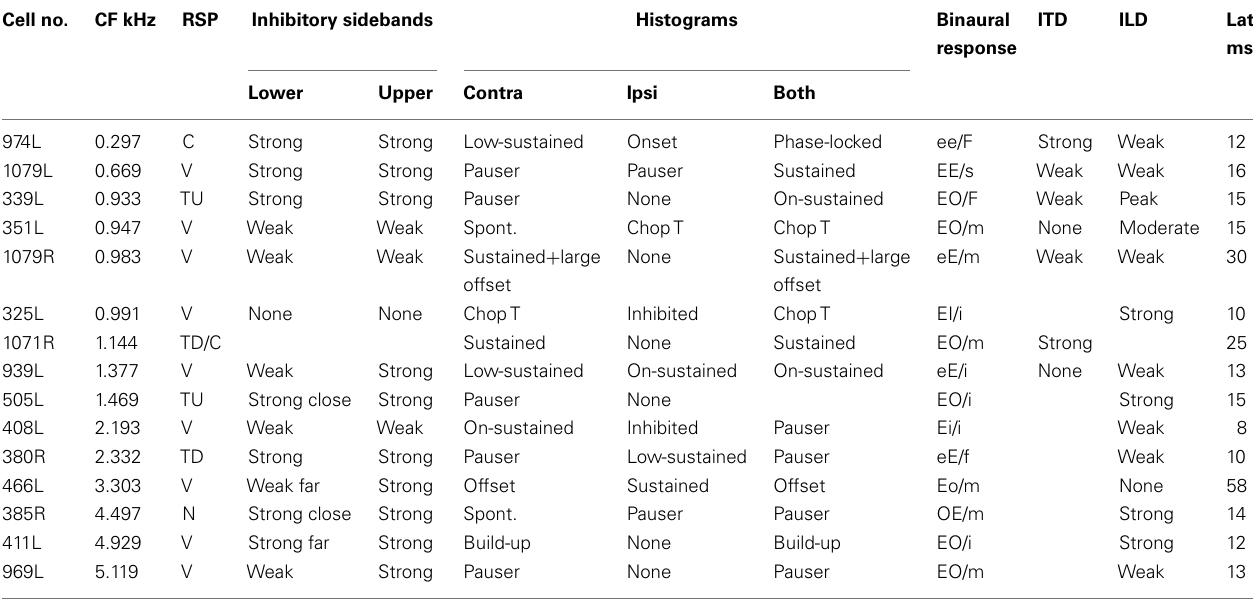
Table 2 | Physiological characteristics of the 15 filled